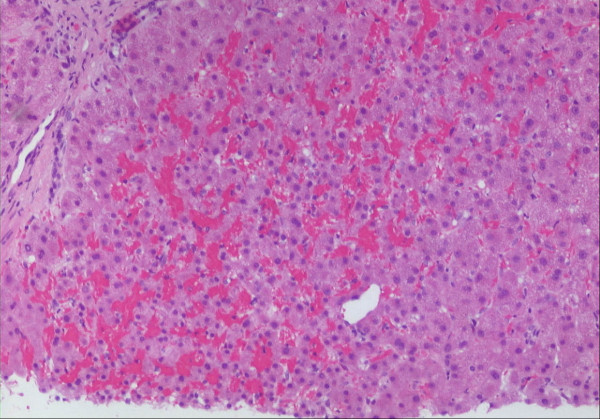
Liver biopsy. Biopsy was performed to rule out a suspected local recurrence. Tissue had been exposed to approximately 20 Gy two months ago. Heterogenous congestion of the sinusoids with beginning atrophy of liver cells. Hematoxylin-eosin, original magnification: ȕ100.